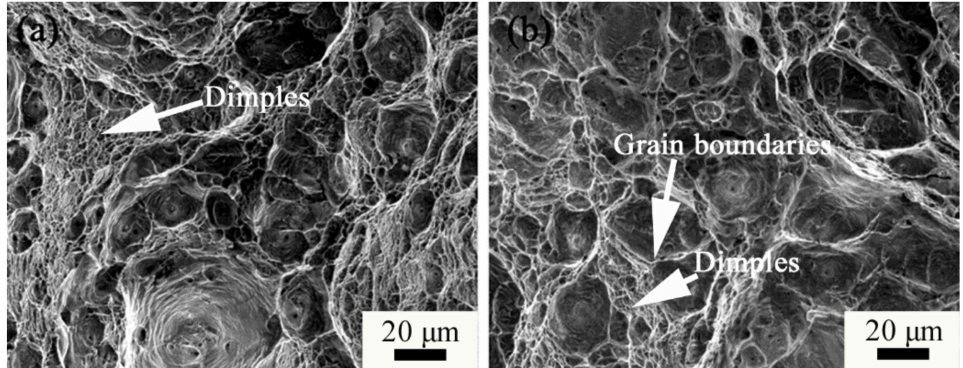
Figure 6. The fractography obtained by SEM of the samples tensiled at ( a ) 400 ◦ C, ( b ) 600 ◦